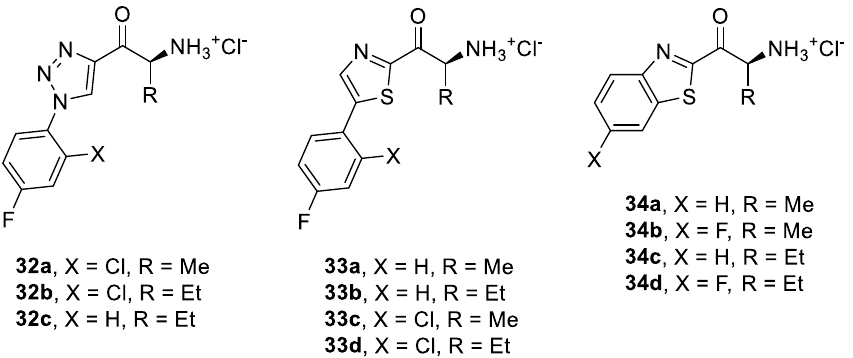
Figure 10. Structures of inhibitors prepared based on SAR optimization.